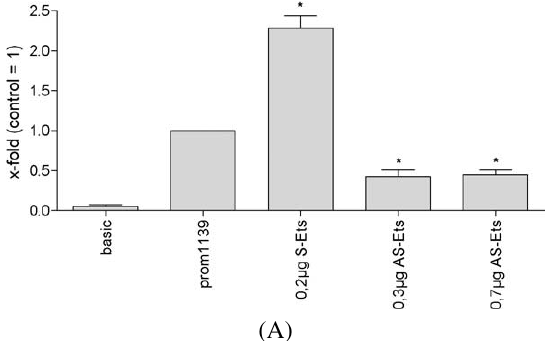
Fig. 3. Regulation of integrin alpha10 promoter activity in melanoma cells. (A) 1139 bp of the integrin alpha10 promoter region were sub- cloned into the pGL3-basic luciferase vector. The promoter construct -1139 was transiently transfected into melanoma cells in combina- tion with expression plasmids for Ets-1 (S-Ets) or antisense plasmids for Ets-1 (AS-Ets), respectively. Promoter activity was analyzed, ac- tivity of pGL3-basic was used as a control. Reporter gene expression revealed promoter regulation by the transcriptional regulator Ets-1 (*: p < 0 . 05). (B) Gel mobility shift assay confirmed Ets-1 binding to the integrin alpha10 promoter. The Ets-1 binding was confirmed using oligonucleotides spanning the Ets-1 binding region (wt Ets-1) of the integrin alpha10 promoter and nuclear extract of Mel Im cells (lane 2). For competition experiments unlabeled wt Ets-1 (lane 4) and mut Ets-1 (lane 3) oligonucleotides were used. Lane 1 shows the labeled oligonucleotide without nuclear extract. (C) AP-2 downregu- lated integrin alpha10 promoter activity in a dose-dependent fashion (*: p < 0 .